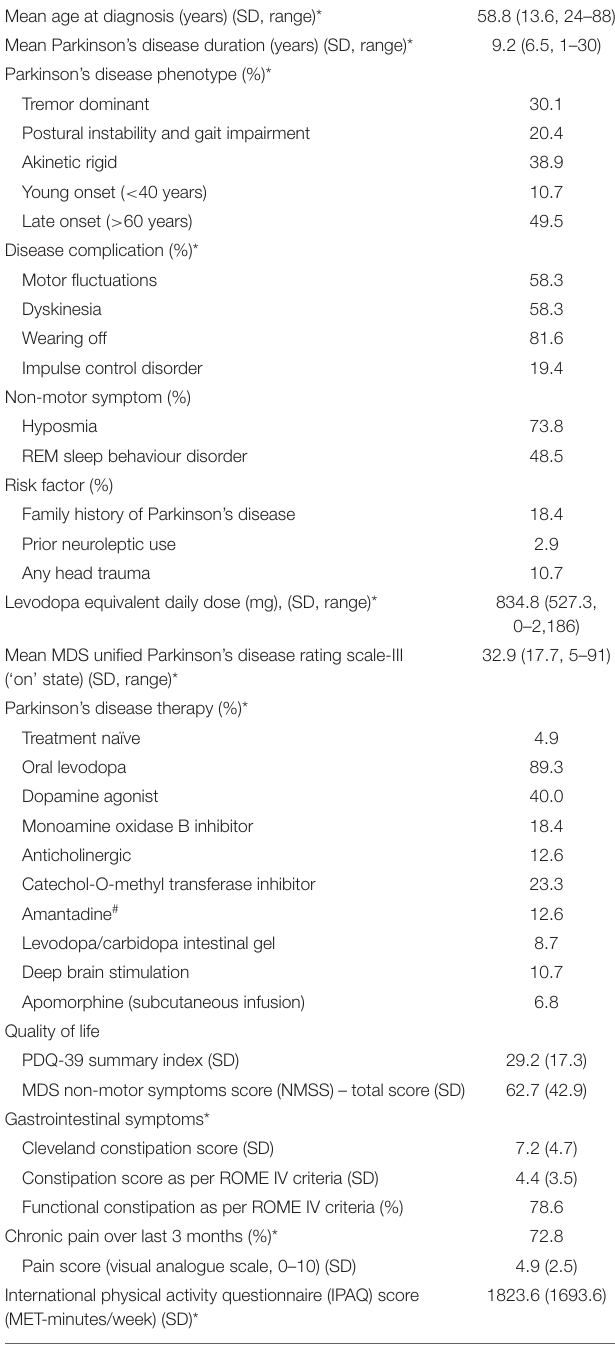
TABLE 2 | Parkinson’s disease clinical